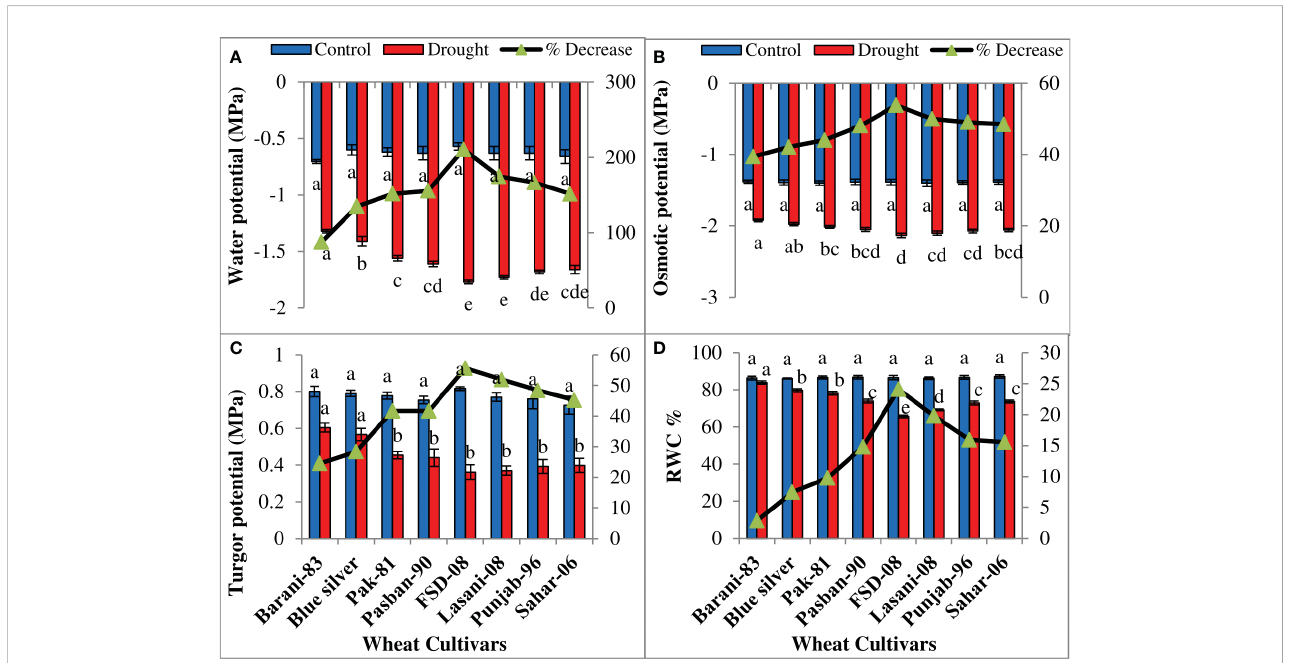
FIGURE 4 Water relations attributes of selected wheat cultivars subjected to control or drought stress at adult stage. Means (± SE; n=5) are presented on the primary vertical axis, while percent decrease value is presented on the secondary vertical axis. Different letters represent signi fi cant differences among cultivars at p < 0.05 according to LSD test. (A) Water potential, (B) osmotic potential, (C) turgor potential, and (D) % relative water